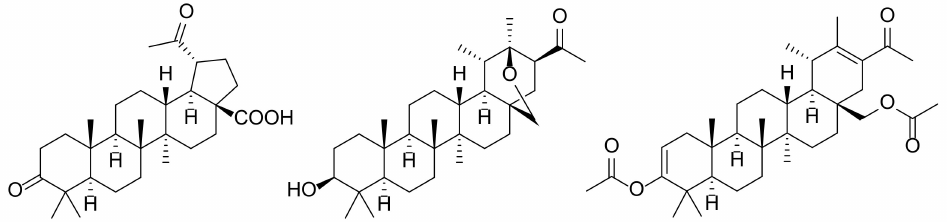
Figure 2. Platanic acid and 18 α ,19 β H-ursane type derivatives as new scaffolds for further modifica- tions toward anticancer